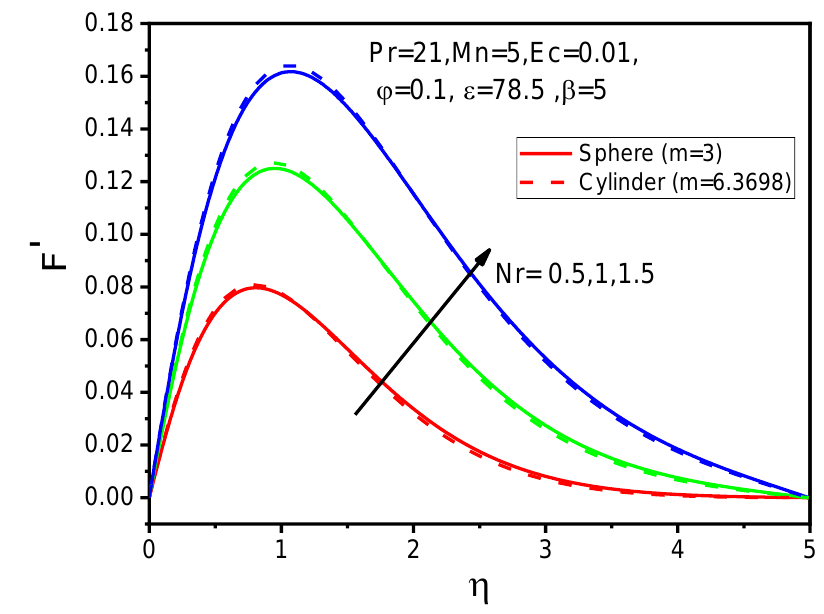
Figure 13. (Case b): Variations of F (cid:48) for Nr = 0.5,1,1.5 against η